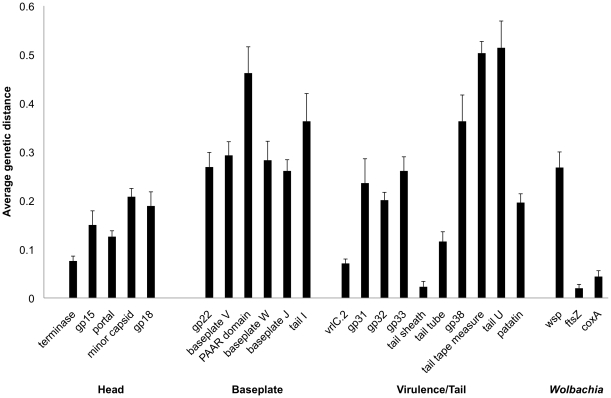
Mean genetic distance of WO and Wolbachia genes.The average genetic distance and standard error was calculated for genes across Wolbachia prophage WO haplotypes. The values for the hypervariable Wolbachia surface protein gene wsp and the highly conserved Wolbachia housekeeping genes coxA and ftsZ are provided for comparison. Black bars represent genes having a predicted function while gray bars represent genes for which no function can be predicted.